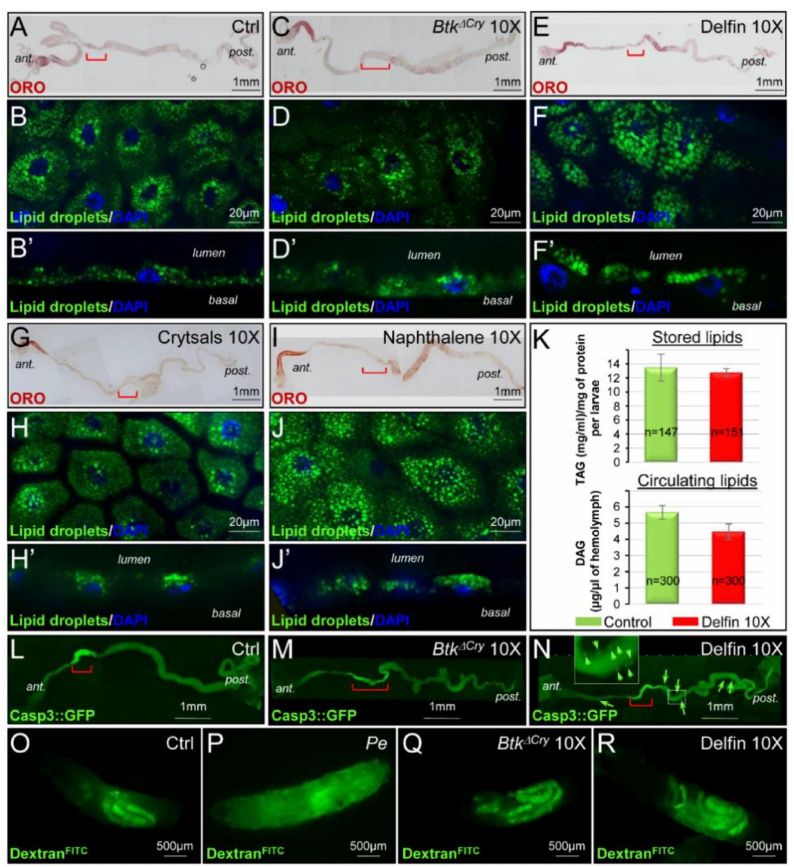
Figure 6. Btk bioinsecticides impacts on gut integrity. L3 raised on a control medium ( A – B’ ) or a medium contaminated with Btk ∆ Cry 10X ( C – D’ ), Delfin 10X ( E , F ), purified Crystals 10X ( G – H’ ), naphthalene sulfonic acid 10X ( I – J’ ). ( A – J’ ) Labeling of lipid droplets with ORO (red, ( A , C , E , G , I )) or with Bodipy (green, ( B , B’ , D , D’ , F , F’ , H , H’ , J , J’ )). DAPI (4 (cid:48) ,6-diamidino-2-phenylindole) staining in blue marks the nuclei. Midguts are oriented anterior to the left. Red brackets delineate the acidic region of the midgut. ( B’ , D’ , F’ , H’ , J’ ) are x / z section with the apical pole of the epithelium facing the lumen. ( K ) Stored (TAG, upper panel) and circulating (DAG, lower panel) lipid dosages in control larvae (green bars) and in larvae raised on Delfin 10X contaminated medium (red bars). ( L – N ) myo1A > Casp::GFP larvae raised on control medium ( L ) or on a medium contaminated with Btk ∆ Cry 10X ( M ) or Delfin 10X ( N ). Arrows point to enterocytes in which Caspase 3 is activated. ( O – P ) L3 raised on a medium complemented with Dextran FITC ( O ) or with Dextran FITC and contaminated with P. entomophila ( Pe ) ( P ), with Btk ∆ Cry 10X ( Q ) or Delfin 10X ( R